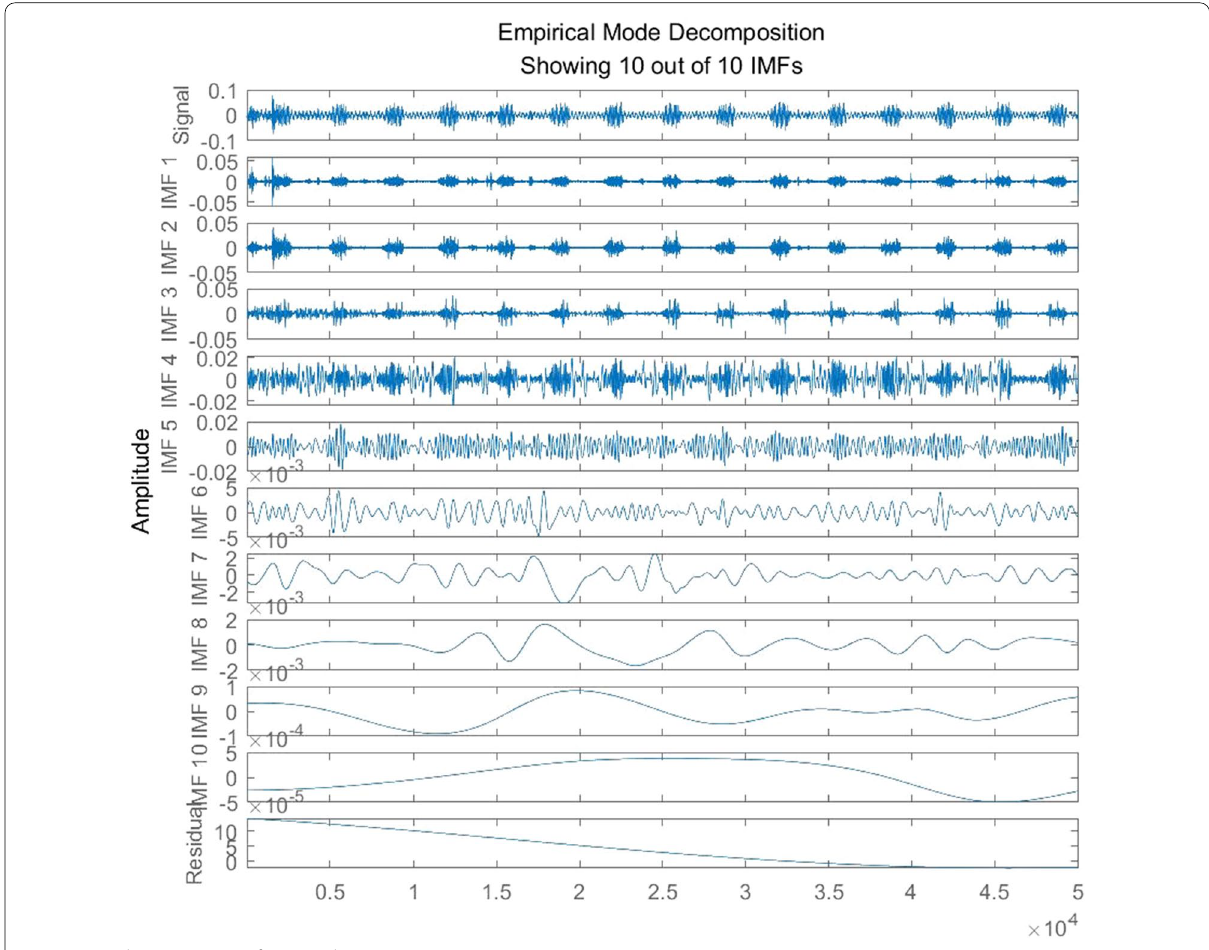
Fig. 6 EMD decomposition of AE signals